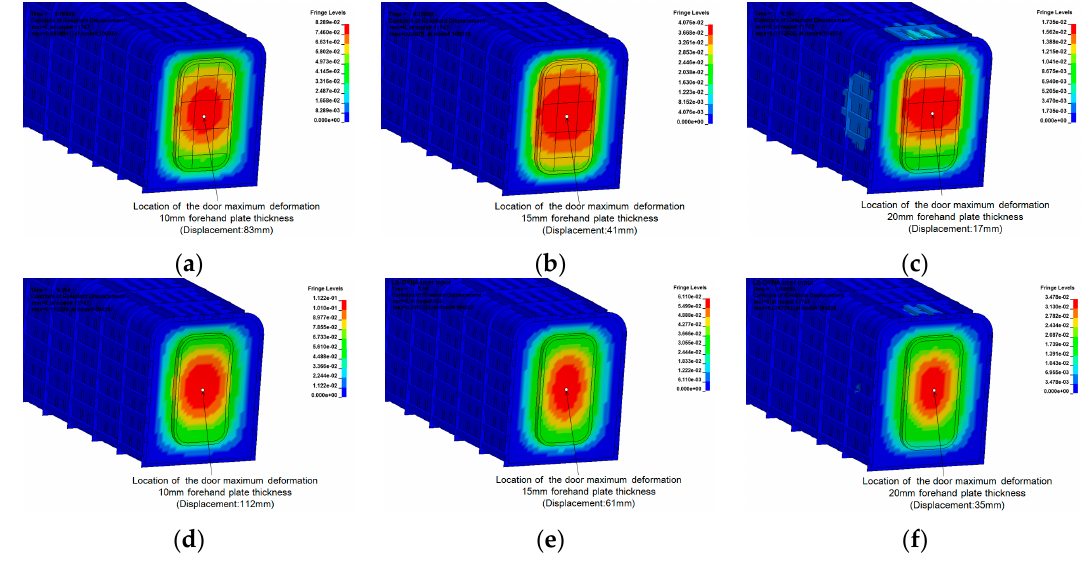
Figure 9. Maximum deformation of the door with different forehand plate thicknesses. ( a ) C1; ( b ) C2;